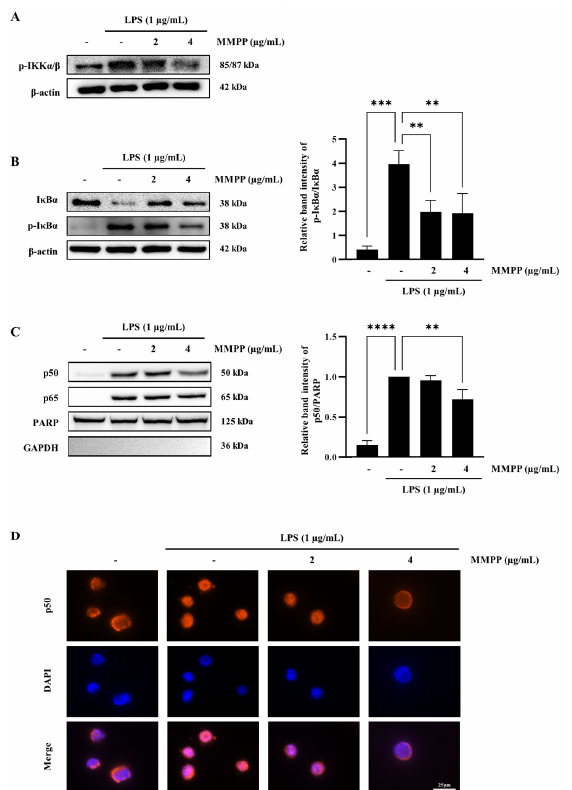
Figure 3. Inhibitory effects of MMPP on the expression of p-IKK α / β , p-I κ B α /I κ B α , NF- κ B, and MAPKs in LPS-stimulated THP-1 cells. THP-1 cells were pretreated with MMPP (2 and 4 µg/mL) for 1 h and treated with LPS (1 µg/mL) for 30 min ( A ), 45 min ( B ), and 90 min ( C , D ). ( A ) The p-IKK α / β levels were evaluated by Western blot. ( B ) The p-I κ B α and I κ B α levels were evaluated by Western blot; p-I κ B α to I κ B α were evaluated by ImageJ software. Data are presented as the mean ± SD ( n = 3); ** p < 0.01, and *** p < 0.001 by one-way ANOVA. ( C ) The nuclear translocations of p50 and p65 were evaluated by Western blot. PARP and GAPDH were used as positive and negative controls, respectively, for the nuclear and cytosolic fractions. The relative band intensities of p50 to PARP were evaluated by ImageJ software. Data are presented as the mean ± SD ( n = 3); ** p < 0.01, and **** p < 0.0001 by one-way ANOVA. ( D ) The nuclear translocation of p50 was evaluated by immunofluorescence staining; p50 was labeled with Cy3 (red) in cells, and nuclei were labeled with DAPI (blue). ( n = 3) Scale bar = 25 µ